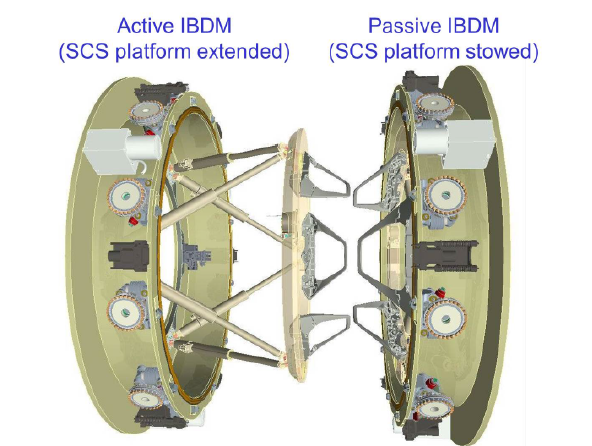
Figure 1. Illustration of the active and passive modules for space IBDM (International Berthing and Docking Mechanism) rendezvous/contact. In the context described in our methodological approach, each module is a dynamic